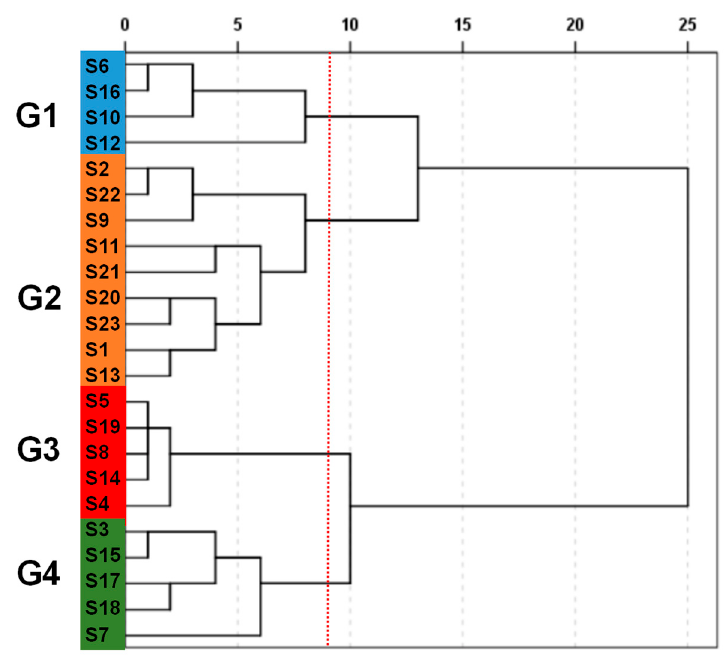
Figure 3. Dendrogram of nine chemical compositions for P. tenuifolia of different origins. G1: group 1; G2: group 2; G3: group 3; G4: group 4.